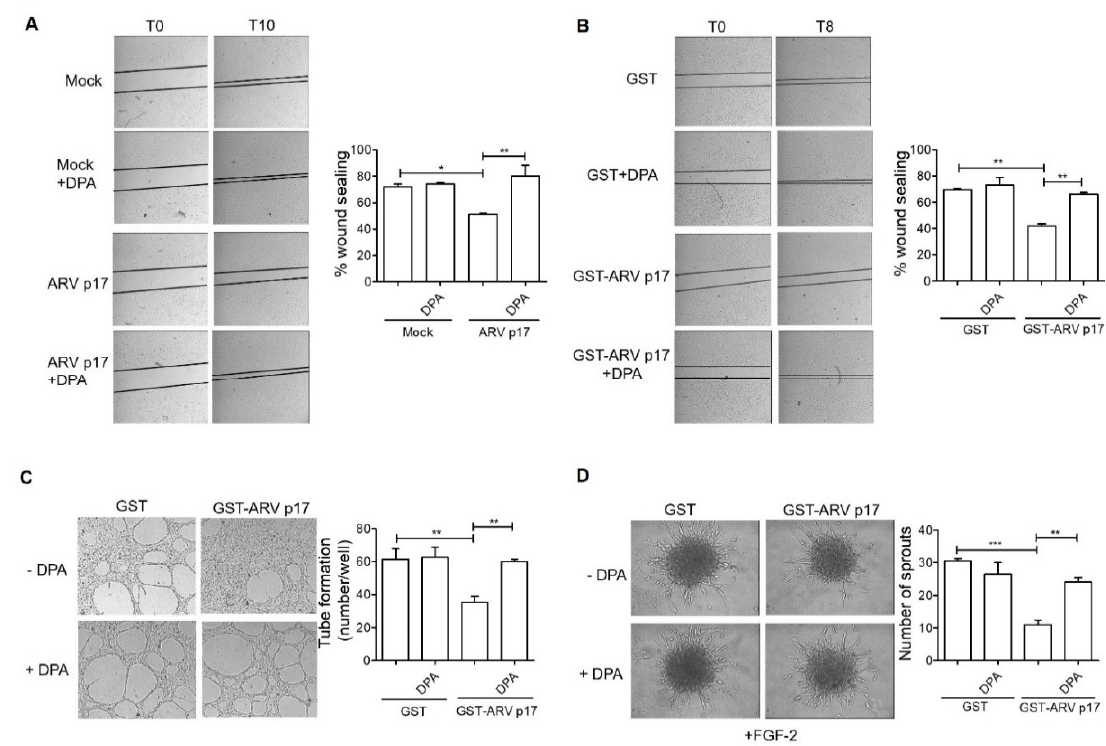
Figure 7. Effect of Diprotin A (DPA) on ARV p17 activities. ( A ) Wound healing assay in the presence of DPA (10 µ M) to assess migratory activity of ECs pretreated with conditioned medium from Mock- and ARV p17-expressing cells (original magnification, 4 × ). The wound width was measured, and the relative wound area was calculated as the ratio of the remaining area at the 10 h time point to the 0 h starting point. Values are the mean ± SD of one representative experiment out of three with similar results, performed in triplicates. Statistical analysis was performed by one-way ANOVA and Bonferroni’s post-test was used to compare data. * p < 0.05; ** p < 0.01. ( B ) Wound healing assay in the presence of DPA (10 µ M) to assess migratory activity of ECs pretreated with recombinant GST or GST-ARV p17 (10 ng/mL) (original magnification, 4 × ). The wound width was measured, and the relative wound area was calculated as the ratio of the remaining area at the 8 h time point to the 0 h starting point. Values are the mean ± SD of one representative experiment out of three with similar results, performed in triplicates. Statistical analysis was performed by one-way ANOVA and Bonferroni’s post-test was used to compare data. ** p < 0.01. ( C ) Tube formation assay in the presence of DPA (10 µ M) to assess capillary-like structures formation in GST- and GST-ARV p17-pretreated cells. Pictures were taken after 6 h of culture (original magnification, 4 × ). Closed rings were counted as a parameter for quantification of tube formation. Values are the mean ± SD of one representative experiment out of three with similar results, performed in triplicates. Statistical analysis was performed by one-way ANOVA and Bonferroni’s post-test was used to compare data. ** p < 0.01. ( D ) 3D spheroid assay in the presence of DPA (10 µ M) and FGF-2 (100 ng/mL) to assess sprout formation in GST- and GST-ARV p17-pretreated cells (original magnification, 20 × ). The bar graph shows the average number/spheroid of EC sprouts. Pictures are representative of one out of three independent experiments with similar results. Values are the mean ± SD of one representative experiment out of three with similar results, performed in triplicates. Statistical analysis was performed by one-way ANOVA and Bonferroni’s post-test was used to compare data. ** p < 0.01; *** p <